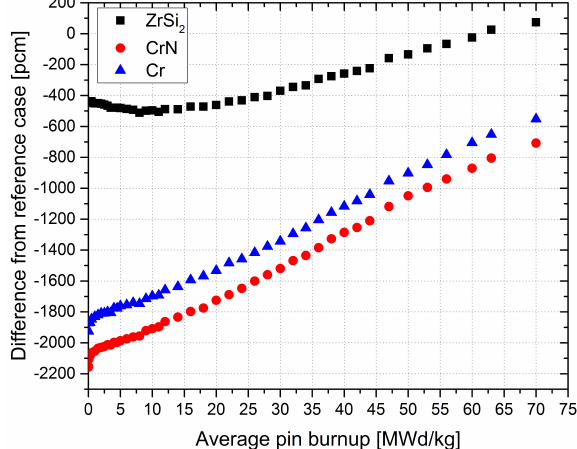
Figure 5. Multiplication factor dependency on bur- nup value for 70 µm